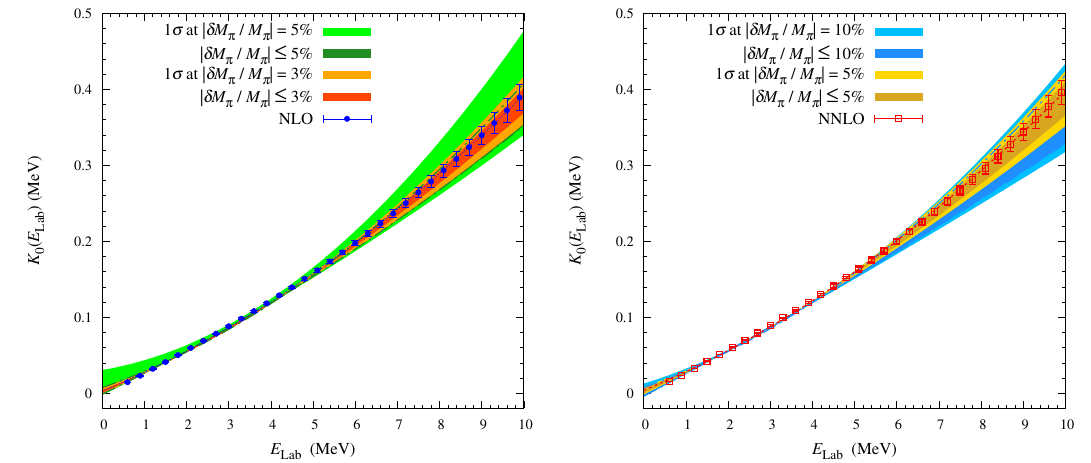
Figure 6 . Pion mass dependence of the S-wave effective range function. Left panel: NLO results. The blue points refer to the results without pion mass variation, the red and dark green bands refer to changes by ± 5% and ± 10% , in order, and the orange and light green bands are the corresponding 1 σ uncertainties. Right panel: NNLO results. The red squares refer to the results without pion mass variation, the golden and dark blue bands refer to changes by ± 5% and ± 10% , in order, and the yellow and light blue bands are the corresponding 1 σ